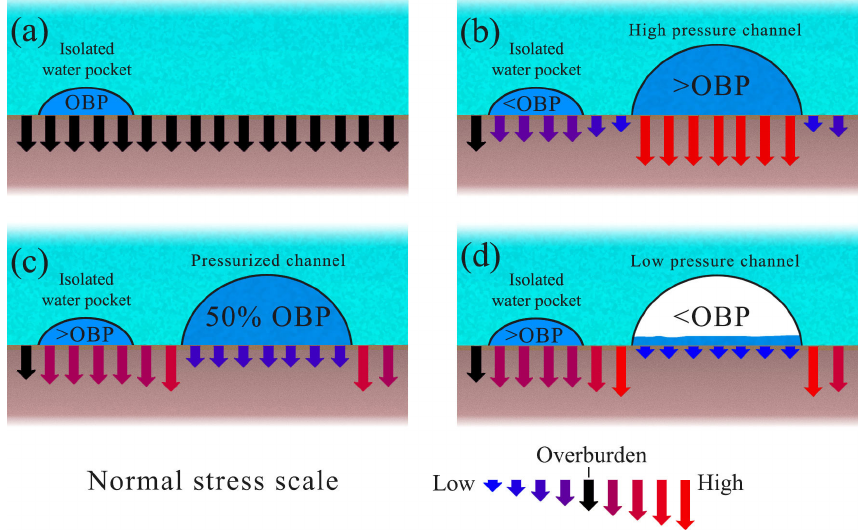
Figure 1. Effect of ice overburden pressure (OBP) and normal stress transfers on isolated water pockets. (a) In the absence of an active drainage system, the water pressure in an isolated water pocket reaches equilibrium close to overburden pressure. (b) A conduit with an internal water pressure above overburden reduces the normal stress in the surrounding bed, leading to a water pressure below overburden on nearby isolated water pockets. (c–d) A conduit with an internal water pressure below overburden increases the normal stress in the surrounding bed leading to above overburden pressures on isolated water pockets. Water pressure variations in a pressurized channel would produce anti-correlated variations in the water pocket. Note that (a) is a stable configuration and (d) is unstable, while the stability of (b) and (c) depend on the